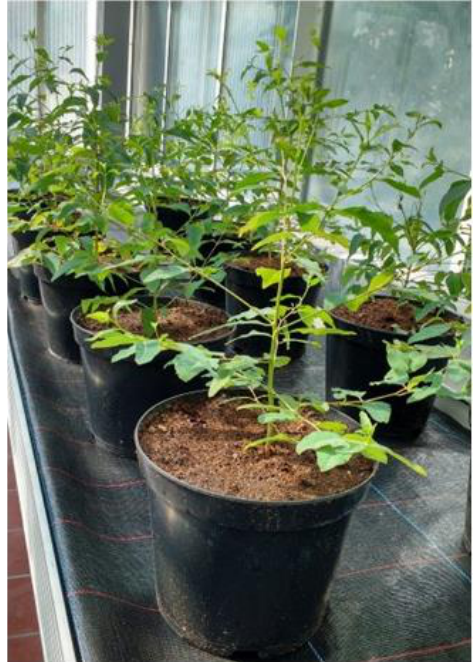
Figure A1. One-year-old Eucalyptus grandis plants. Photograph taken in the experiment-starting day in the green house.